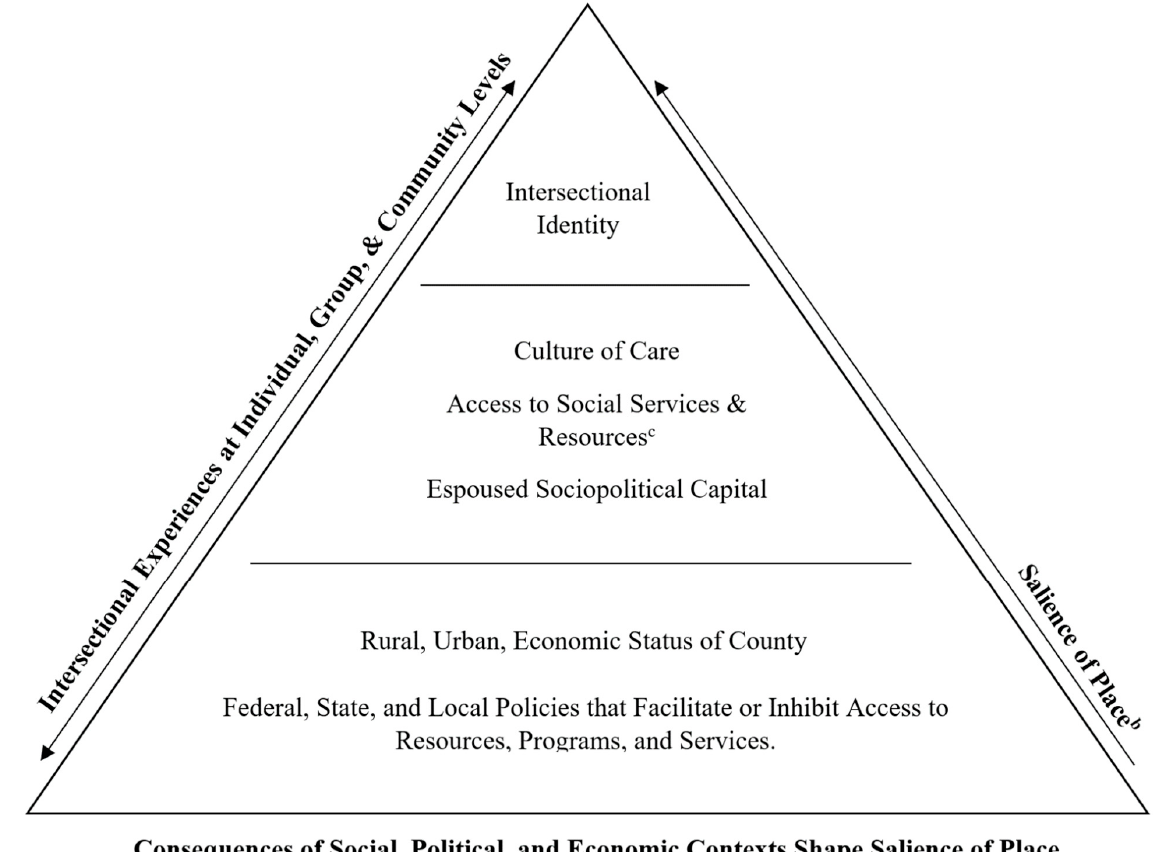
Figure 1. The Intersectional Nature of ACEs Framework a . Note. a Subpopulations experience high-risk conditions as a result of social, political, and economic contexts at individual, group, and community levels due to systemic inequality. Subpopulations identified in our interview data did not comprise an exhaustive list of place-based determinants. To see the comprehensive list of place-based determinants derived from this study which inform the relationship between the salience of place and intersectional experiences, see the Appendix A. b Place-based contexts can determine high-risk conditions and are constructed by the physical nature of place, as well as governing policies, systems, and processes that determine access and availability of resources, programs, and services. However, access to resources, programs, and services is additionally materialized by the culture of care and how individuals, groups, and communities are recognized. Community characteristics can include the physical location of resources, transportation access, and changes in population and place-based crises that compound high-risk conditions (e.g., opioid crisis). c Access to social services and resources mitigates factors that construct high-risk conditions which in turn lessen ACEs.